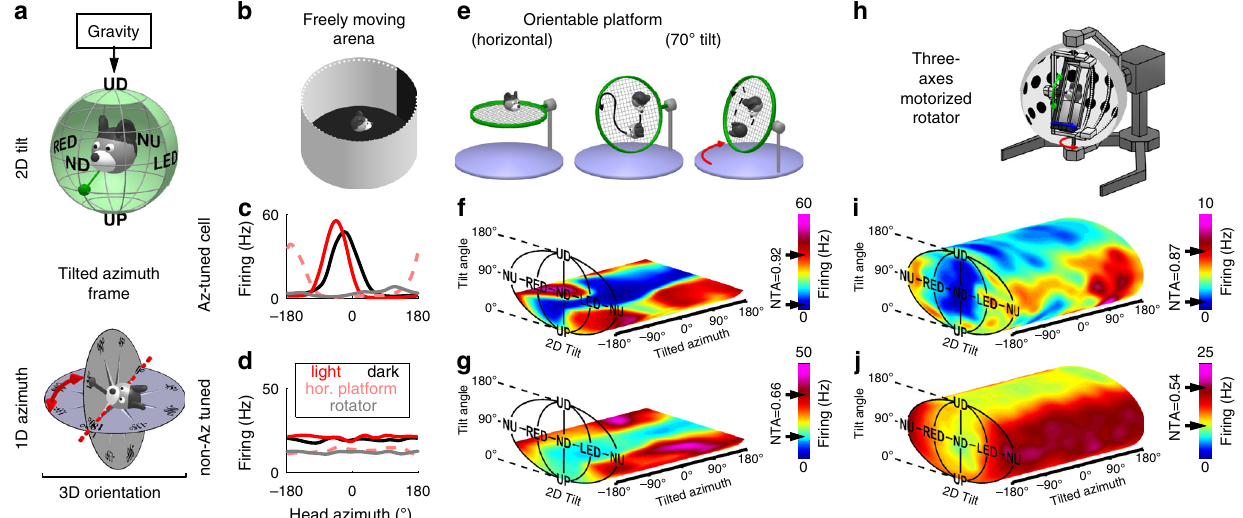
Fig. 1 Three-dimensional response of two example cells. a Proposed framework for 3D orientation. Top: tilt is measured by sensing the gravity vector (green pendulum) in egocentric coordinates, resulting in a 2D spherical topology. Bottom: azimuth has a circular topology, and is measured by rotating an earth-horizontal compass in alignment with the head-horizontal plane (TA frame). b Schematic of the arena used to identify azimuth-tuned cells in the horizontal plane. c , d Example azimuth tuning of a traditional HD cell, i.e. tuned to azimuth (Az-tuned) in the ADN ( c ) and another cell not tuned to azimuth (non-Az-tuned cell) in the cingulum ( d ), as the mouse walks freely in light (red) and darkness (black) in a horizontal arena (shown in b ), on a platform oriented horizontally (shown in e , left; broken pink lines) and in the rotator (shown in h ; gray lines). The azimuth-tuned cell showed signi fi cant tuning with different preferred directions (PD) in all setups, although response was strongly attenuated in the rotator (compare gray with red/pink lines). e Schematic of a 3D orientable platform used to measure 3D tuning. f , g Tuning curves for the two cells in c and d , obtained from responses as the mouse foraged on the orientable platform (shown in e ). Firing rate is shown as a heat map in 3D space (Supplementary Movies 1, 2). The peak and trough of the average tilt response (across all azimuths) are indicated with arrows on the color scale; NTA = (peak-trough)/peak. Note that tuning curves are restricted to 60° tilt (Methods). h Schematic of a rotator used to measure full 3D tuning curves. i , j Tuning curves for the two cells in c , f and d , g as the mouse was passively re-oriented uniformly throughout the full 3D space using the rotator (Supplementary Movies 3 –